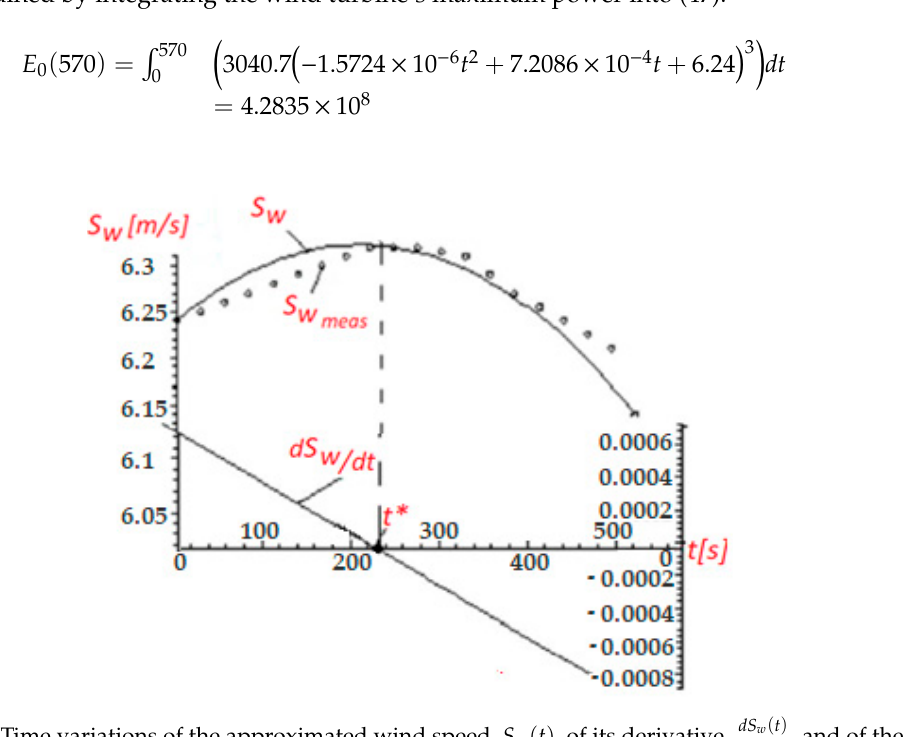
, and of the (cid:3031)(cid:3047) ( t ) , and of the , and of the dt (cid:3031)(cid:3047)